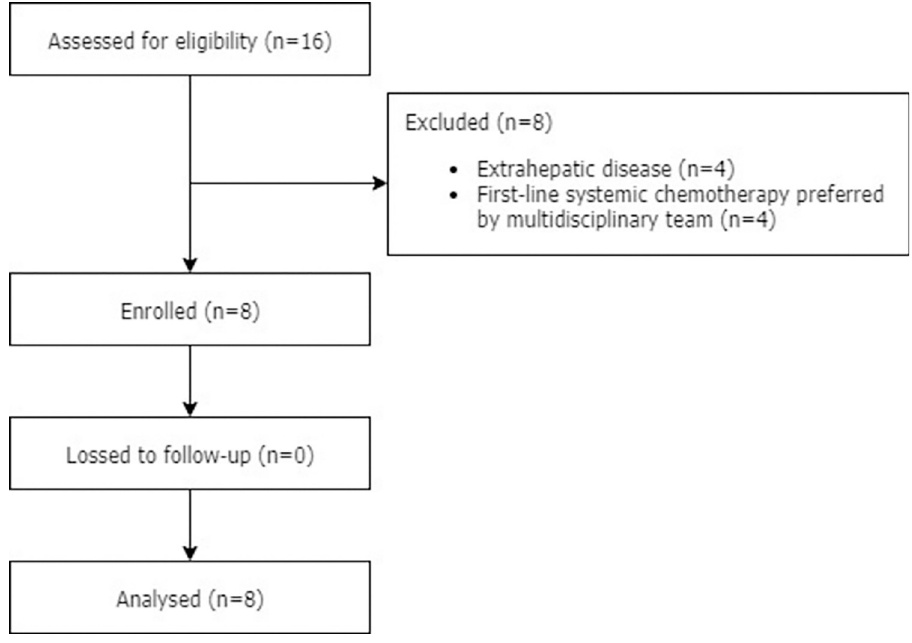
Fig 1. Patient flow